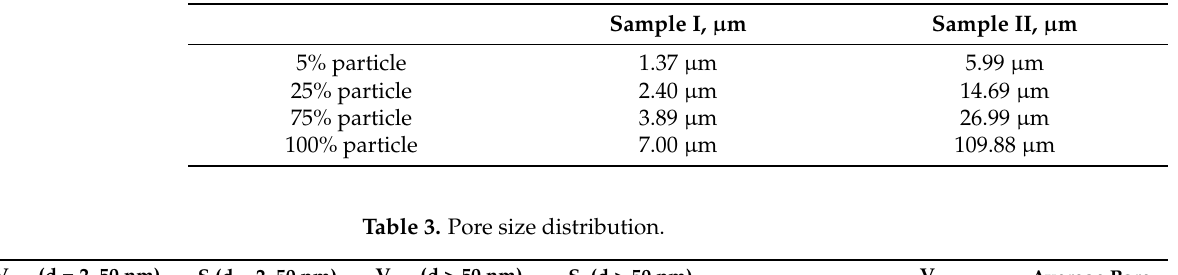
Table 2. Particle size distribution.